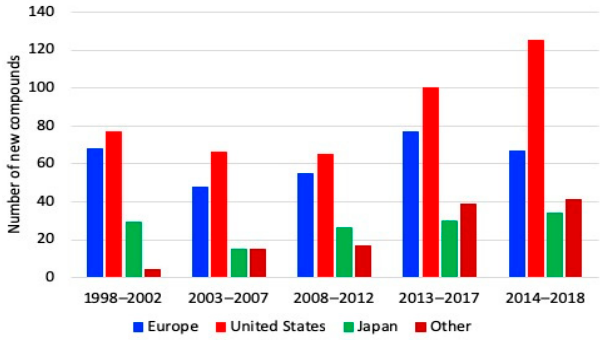
Figure 6. New chemical and biological entities developed between 1992 and 2018 [83].